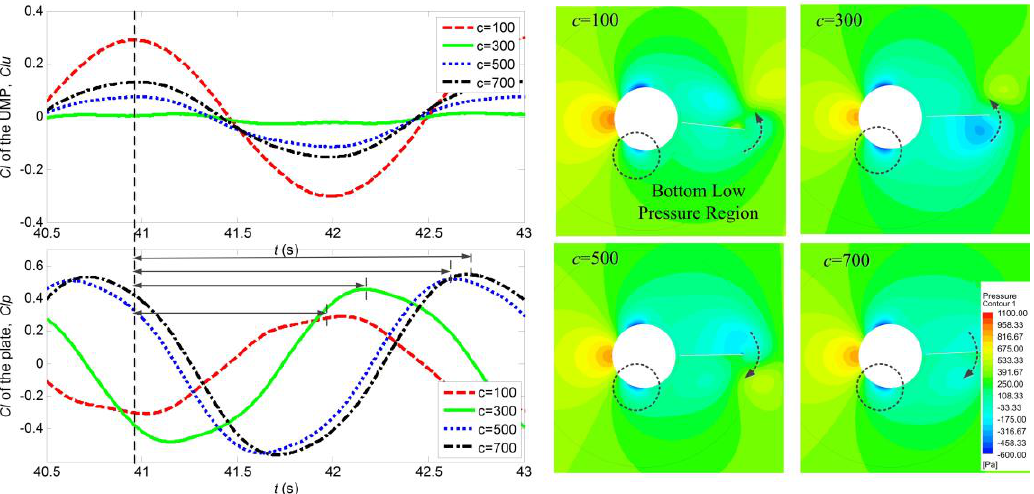
Figure 12. Instantaneous lifts and pressure contours around the UMP for different